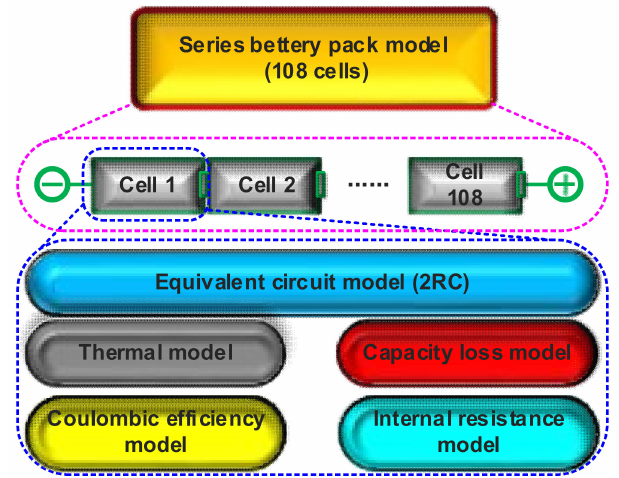
Figure 4. Structure of simulation